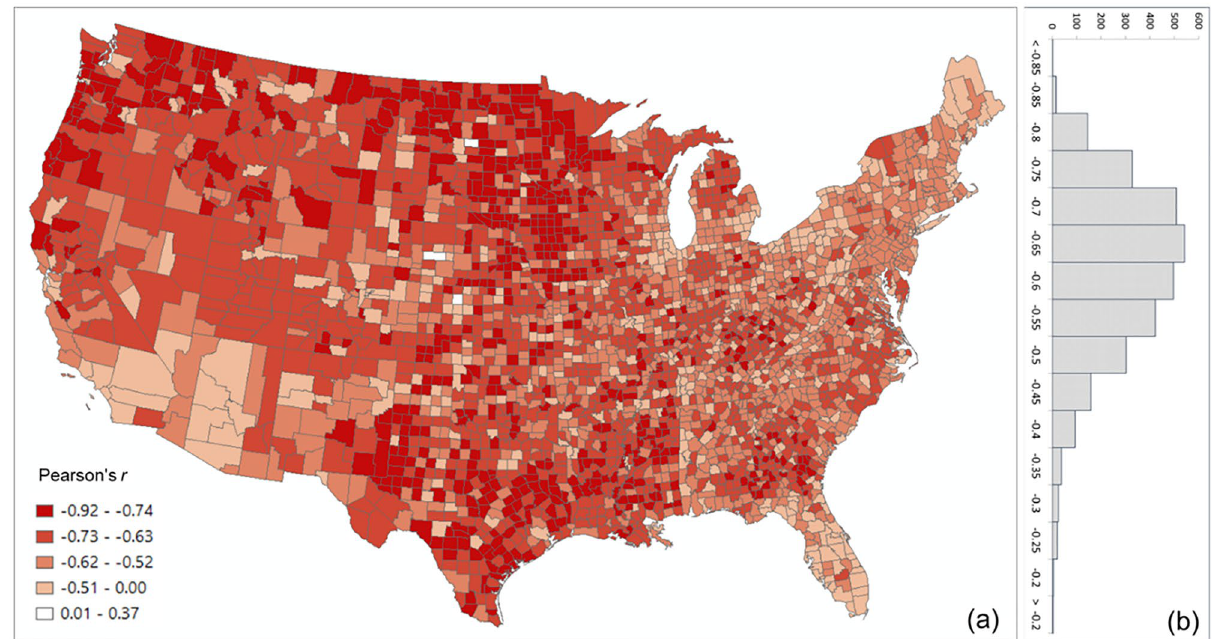
Figure 8. Distribution of the Pearson’s r between log PCI and log distance for all counties ( a ) Spatial distribution, ( b ) histogram . The map was generated using ArcMap version